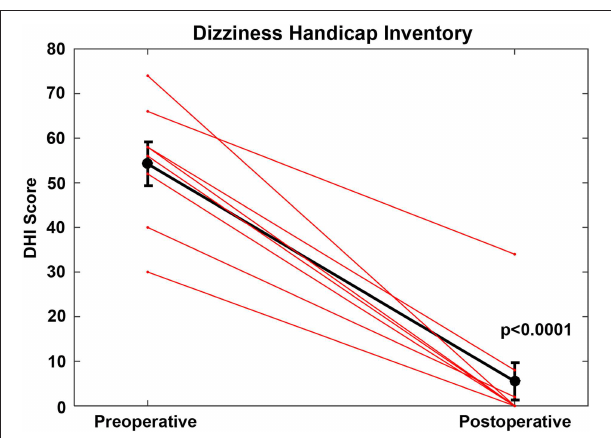
FIGURE 3 | For the cochlea-facial nerve dehiscence cohort who had round window reinforcement procedures performed, the pre-operative mean DHI score was 54.25 (SE 4.9, range 30–74). The post-operative mean DHI score was 5.5 (SE 4.2, range 0–34). This improvement was highly statistically significant (paired t -test, p < 0.0001). These data are plotted as a single black line. Individual patients are plotted as separate lines (red). Copyright © P.A. Wackym, used with